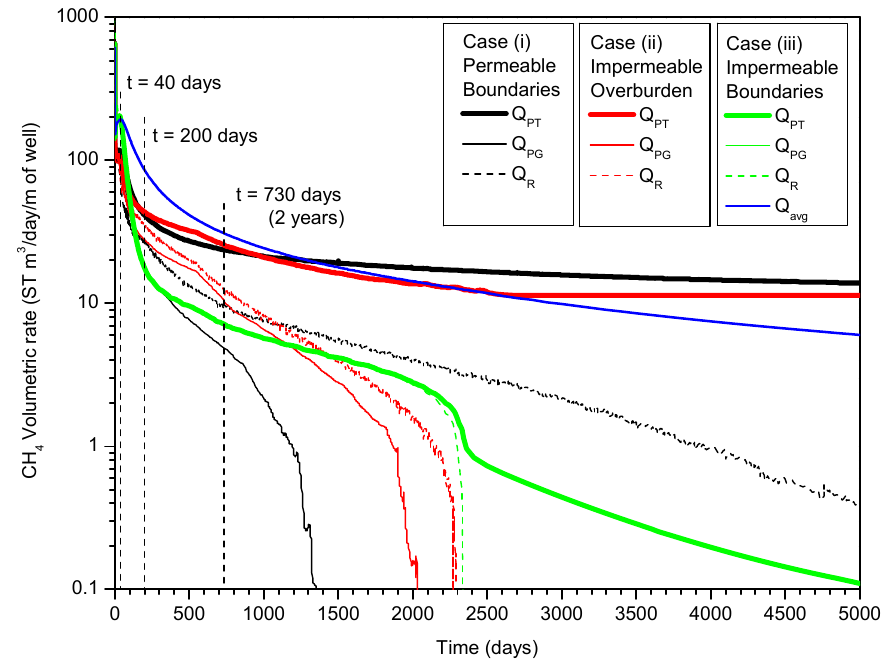
, Q and Q . PT PG R